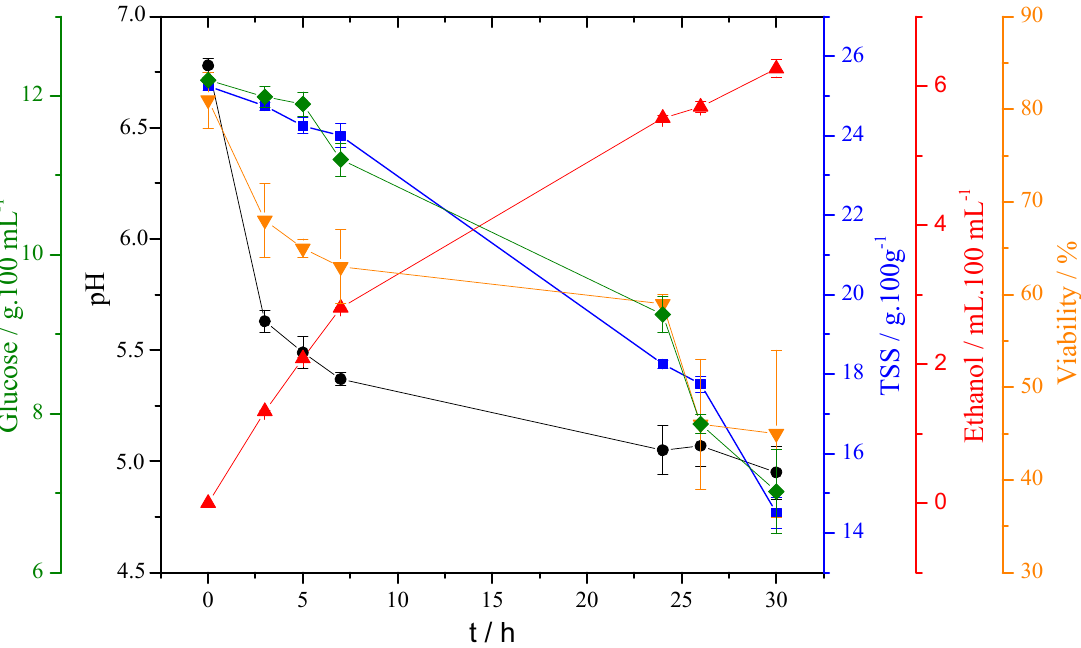
Figure 5. Time variation of the fermentation parameters: pH ( ● ), total soluble solids ( ■ ), percent ethanol ( ▲ ), cell viability ( ▼ ), and glucose ( ♦ ).